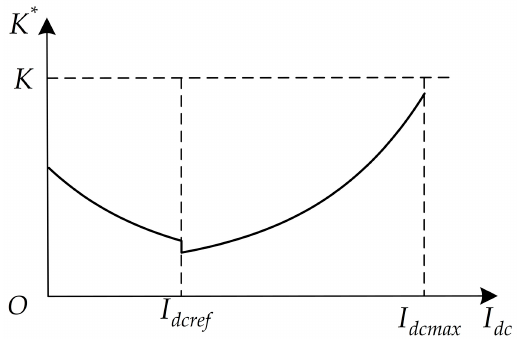
Figure 8. The relationship between the adaptive droop coefficient and the DC current .